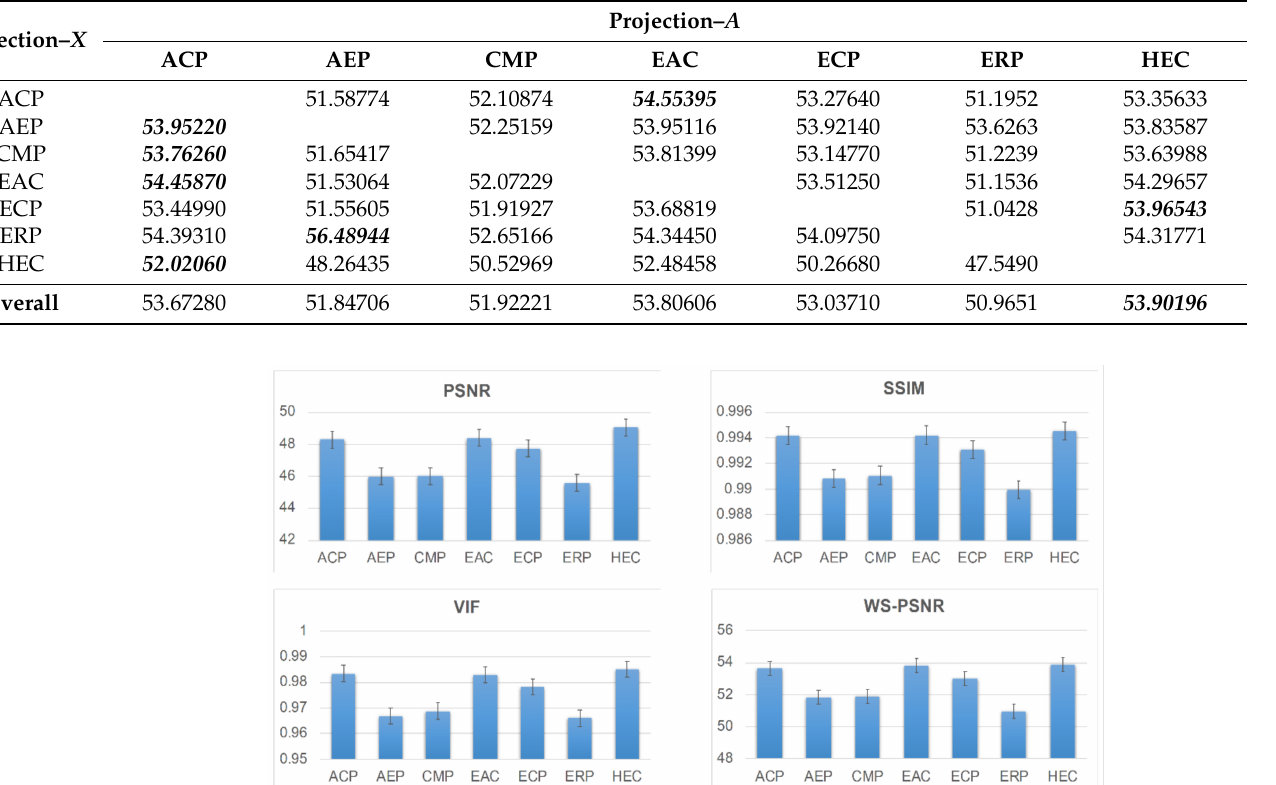
Table 4. Comparison using WS-PSNR (average values at 2K, 4K, and 6K).